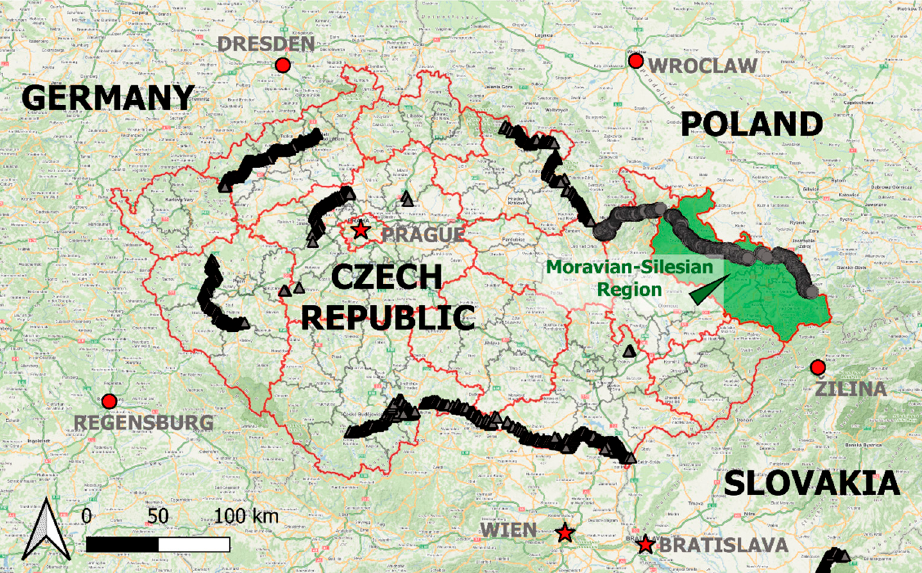
Figure 1. CEFs units on the whole territory of today’s Czech Republic—noticeable continuing line to Slovakia; triangle marks are CEFs units from 1936, dot marks are CEFs units from 1937–1938 [27– 29].